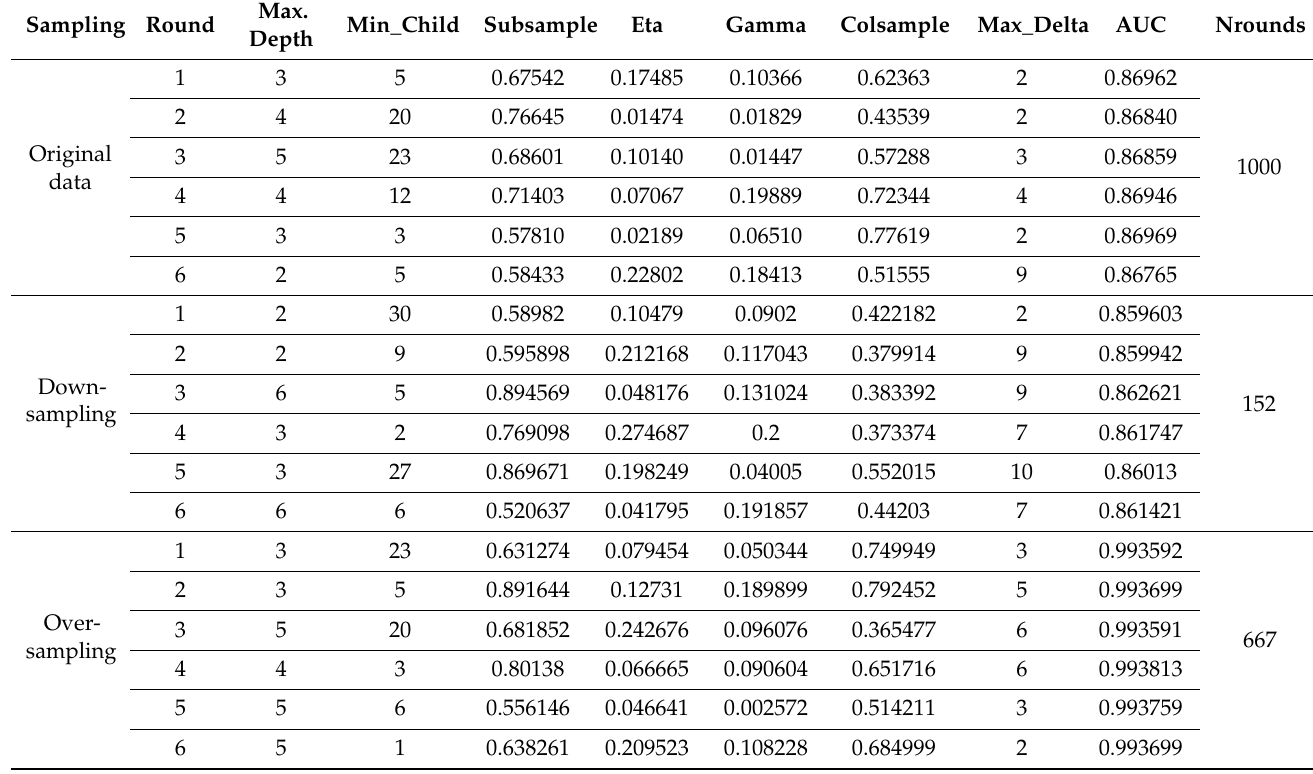
Table A1. Bayesian-parameter-tuning